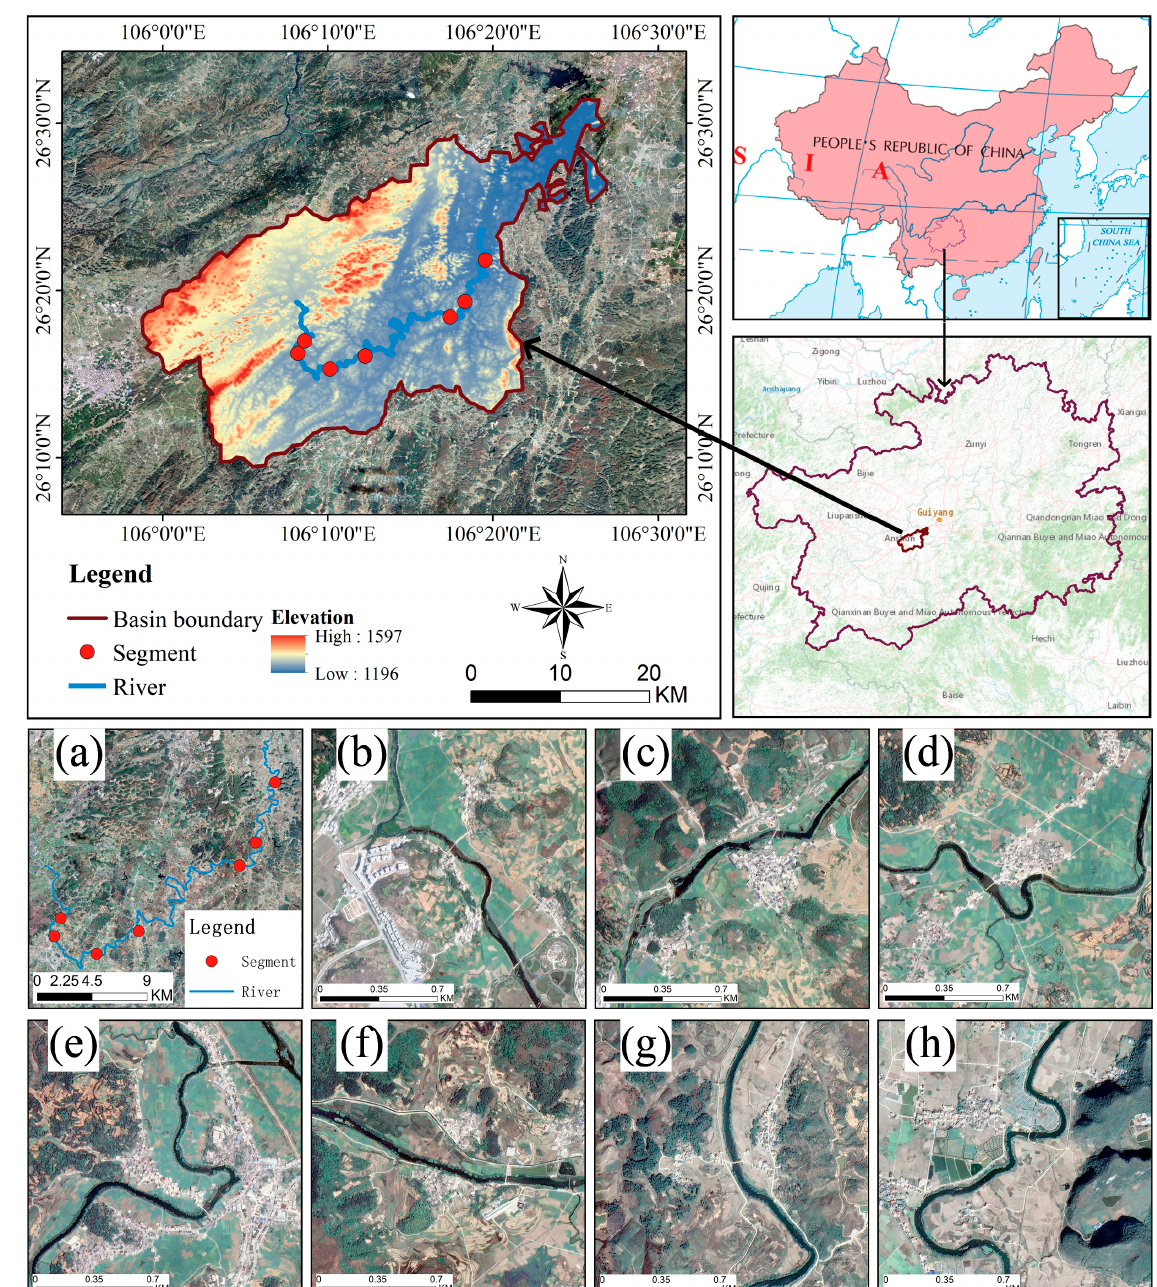
Figure 1. Overview of the research area, including ( a ) the distribution of Remote Sensing Hydrology Stations in the Xingjiang River basin; ( b – h ) the river conditions and surrounding environment of each segment. Satellite images are collected from Google Earth.